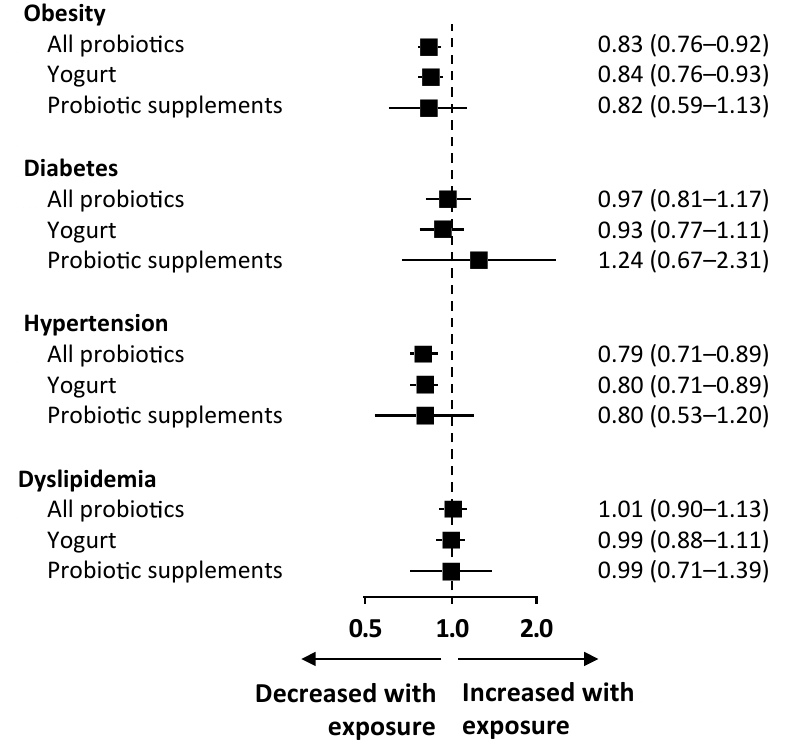
Figure 2. Odds ratio of disease in participants exposed to probiotics compared to those not exposed, according to the origin of probiotics (all probiotics, yogurt, or probiotic supplements). Logarithmic regression models adjusted for age, sex, race, income, education, alcohol intake, smoking status, physical activity, carbohydrates / kcal per day, protein / kcal per day, fiber / kcal per day, and polyunsaturated / saturated fatty acids ratio (model 2). Model 2 also includes BMI in all analyses except in the obesity analysis and includes sodium intake per day only in the hypertension analysis.